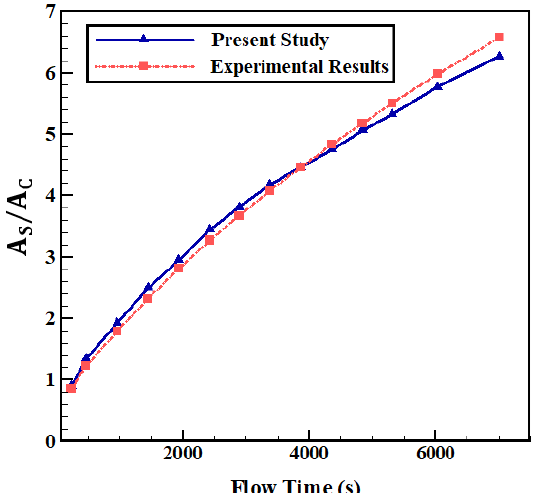
Figure 4. Comparison between the present simulations and the experimental results of Sasaguchi et al. [27,28]. The solid volume ratio (A S /A C ) is the ratio of the solidified area to the total cross-sectional area of the